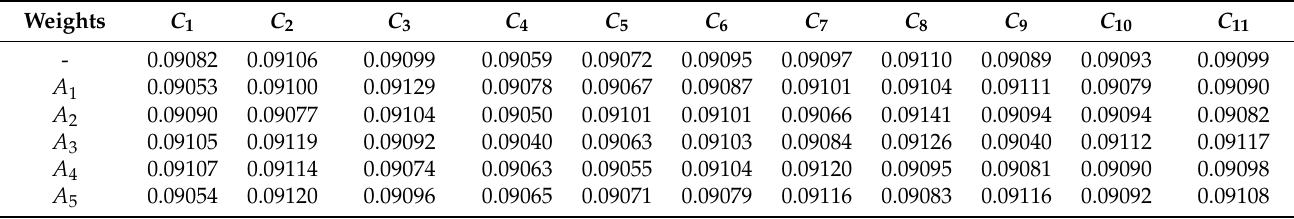
Table 12. Overview of the weights obtained for the decision matrix upon exclusion of